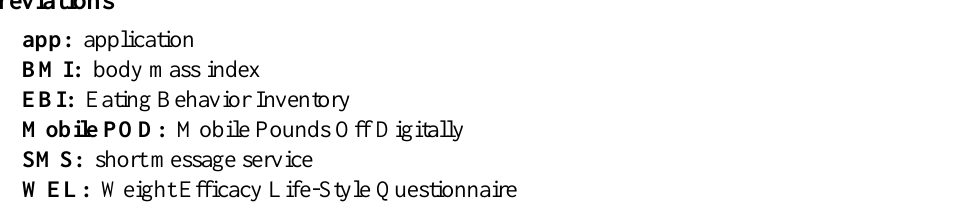
WEL: Weight Efficacy Life-Style